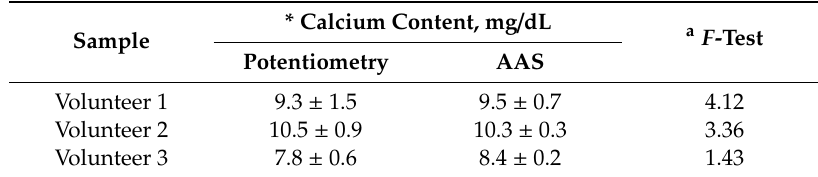
Of calcium in human serum samples using the proposed electrodes and the AAS reference method. * Calcium Content, mg /